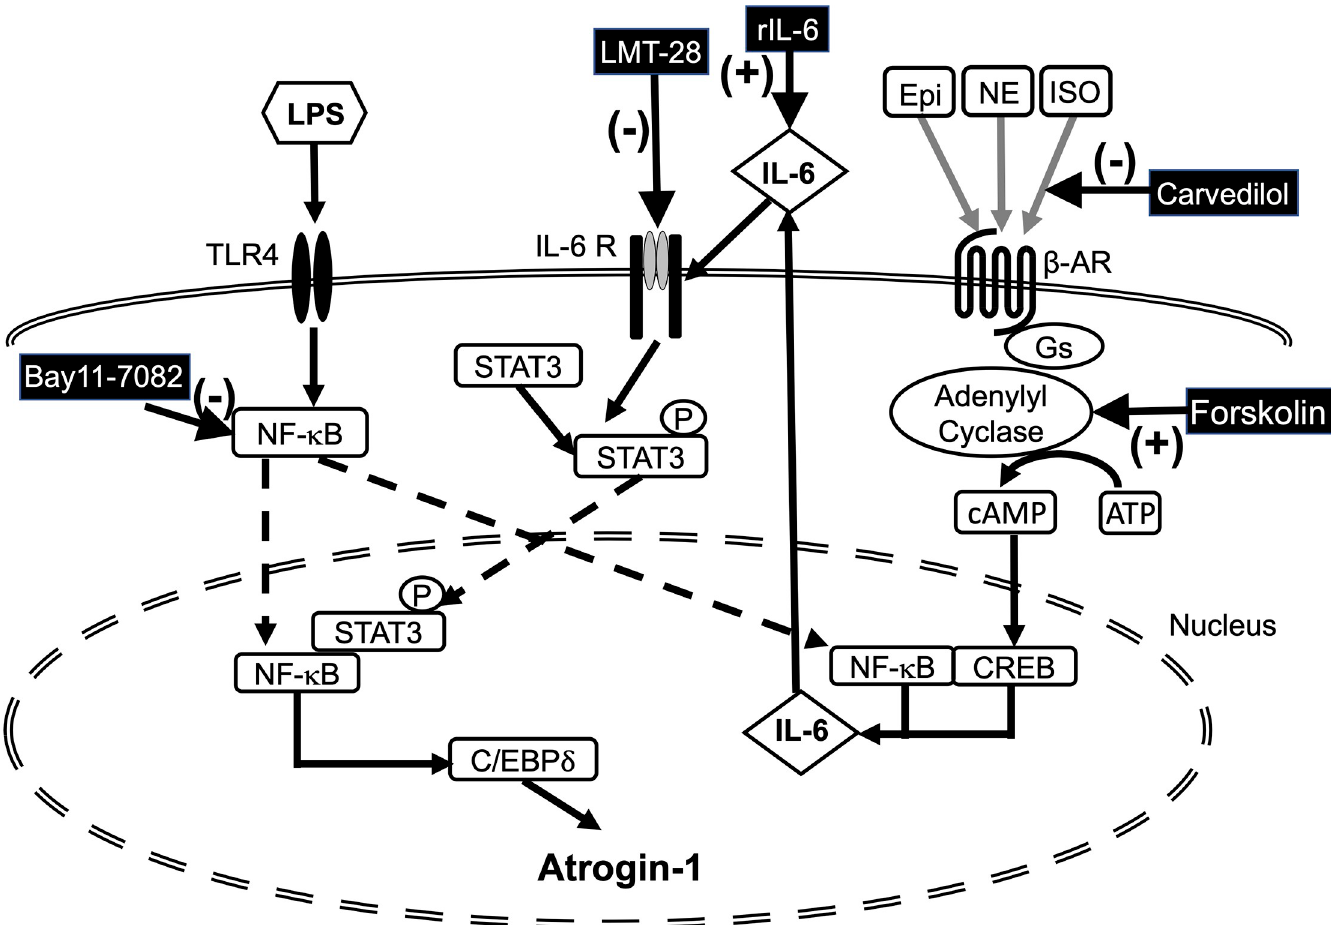
Fig 9. Schematic representation of the effects of catecholamines on LPS-induced myotube wasting. NF- κ B activated by LPS via toll-like receptor 4 (TLR4) induces the expressions of C/EBP δ and Atrogin-1. NF- κ B also induces IL-6 production and STAT3 activation that further facilitates the induction of C/EBP δ and Atrogin-1, thus leading to muscle wasting. The β -adrenergic receptor ( β AR) activated by catecholamines increases cAMP production, and drastically augments LPS-induced IL-6 production, thus leading to further activation of STAT3 and potentiation of the expressions of C/EBP δ and Atroign-1. This results in the exacerbation of muscle wasting. Reagents used in this study, LMT-28, Bay11-7082, Carvedilol, Forskolin, and rIL-6, are also shown in the scheme. The symbols (+) and (-) are used to indicate that the reagent promotes or inhibits the indicated mediator, respectively.